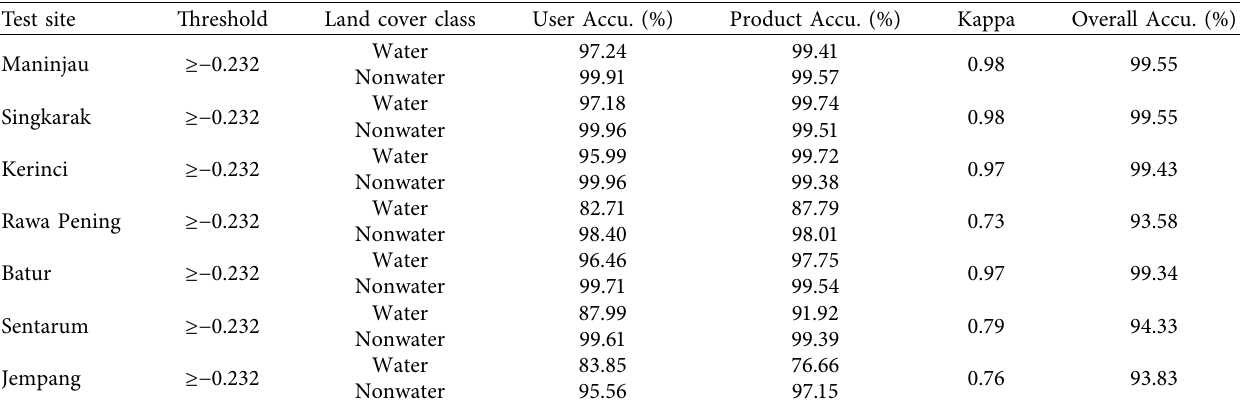
Figure 12: Results of water and nonwater classification based on the natural break threshold (AWEI ≥ − 0.232): (a, b) Tempe Lake; (c, d) Matano Lake; (e, f) Poso Lake; (g, h) Limboto Lake; (i, j) Tondano Lake; and (k, l) Sentani Lake. Table 4: Summary of the classification accuracy of the AWEI threshold improvement based on the results of the natural break threshold to detect lake surface water, tested at several locations that could represent other lake characteristics in